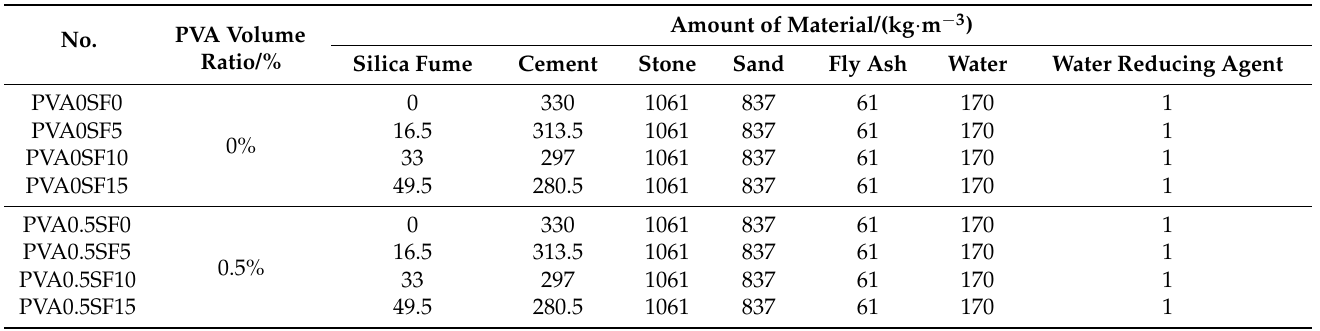
Table 2. Mix proportion design of